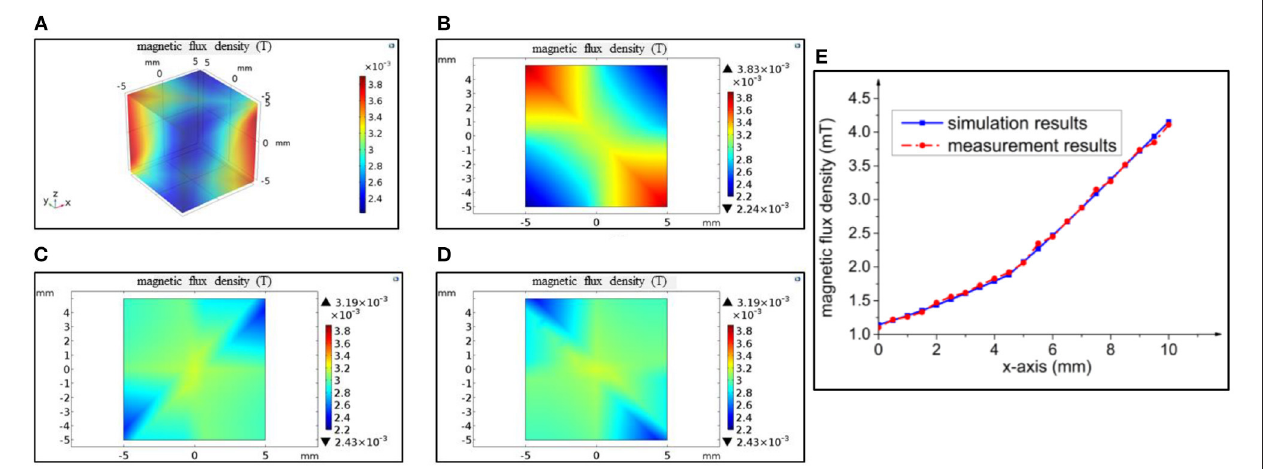
FIGURE 3 | Simulation of the electromagnetic system in the workspace. (A) Three-dimensional (3D) magnetic field distribution; (B) magnetic field distribution in XY-plane; (C) magnetic field distribution in XZ-plane; (D) magnetic field distribution in YZ-plane; (E) comparison between magnetic fields evaluated with COMSOL and measured with gaussmeter in